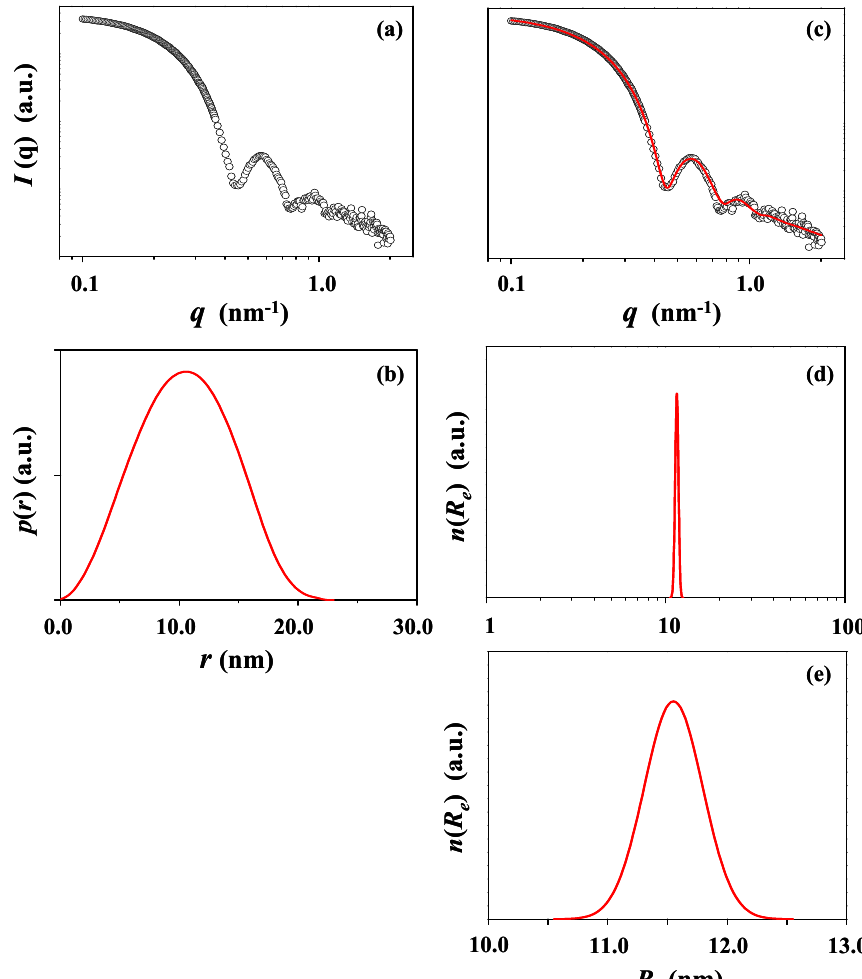
Figure 3. X-ray scattering data analysis of the c -PDGE- b -PTEGGE micelle formed in an ethanol/water (75/25 in wt/wt ) mixture: ( a ) scattering data measured at room temperature; ( b ) pair distance distribution functions p ( r ) obtained by the data analysis using the IFT method; ( c ) data analysis result, where the open dot symbols are the measured data and the red solid line was obtained by fitting the data using the three phase ellipsoid approach; ( d,e ) radius distribution obtained by the data analysis with the three phase ellipsoid approach.